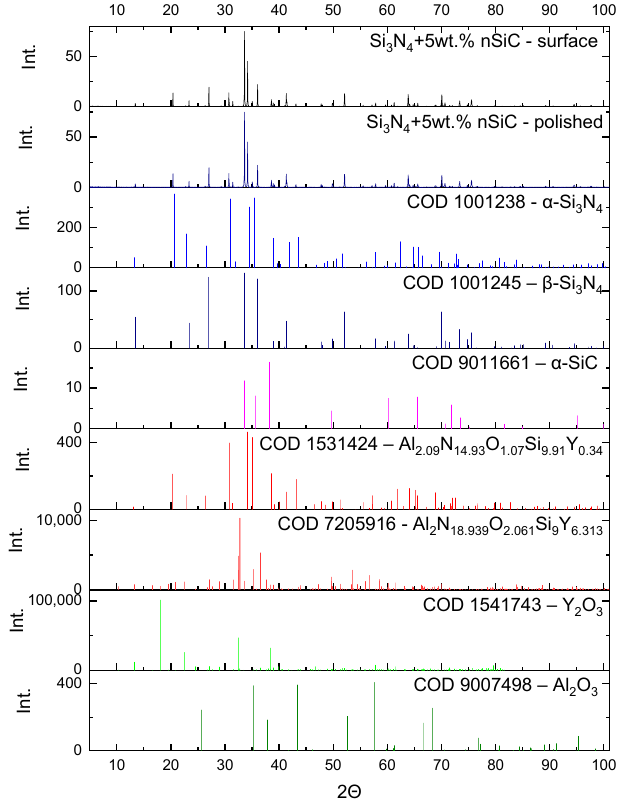
Figure 5. Diffractogram of the Si 3 N 4 -nSiC material containing 5 wt.% of silicon carbide sintered at a temperature of 1800 °C (HIP) and the intensity of the characteristic reflections of the phases present in the sample.